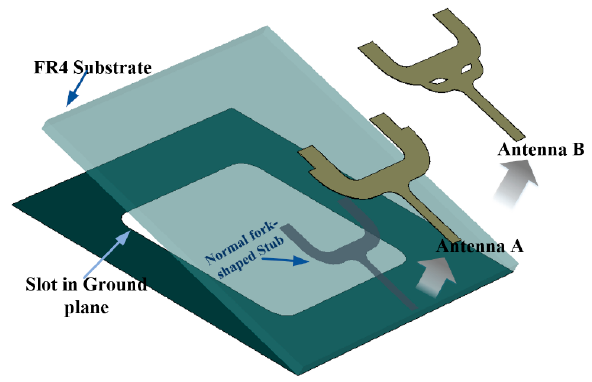
Figure 1. Top views of the two types of proposed antenna.